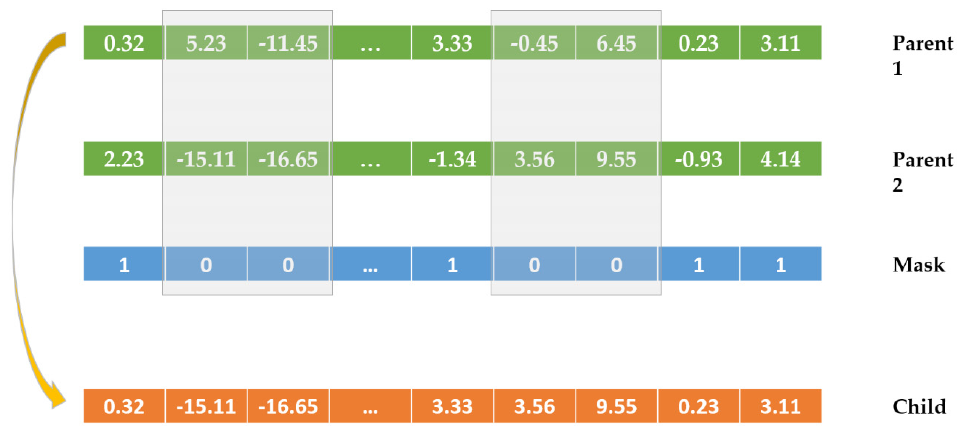
Figure 8. A scattered crossover operator applied on two individuals.